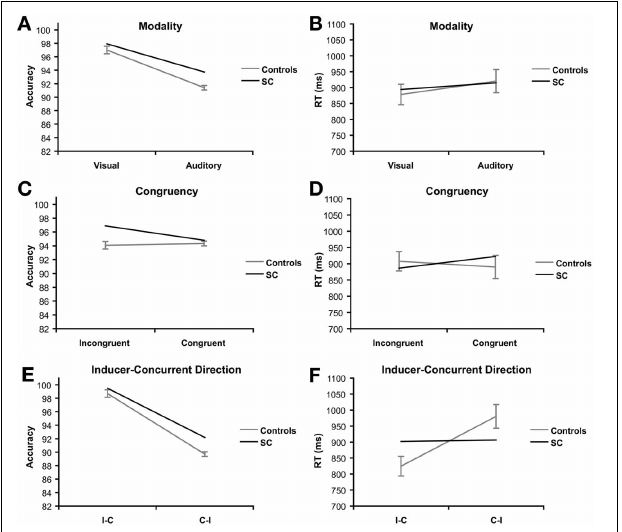
FIGURE 4 | Priming task: 2 × 2 interaction effects of synesthete SC and controls ( N = 16). Interactions are plotted for three factors of interest: modality refers to the visual or auditory presentation of the stimuli. Congruency refers to whether the type of tastes of the prime and target words were congruent (e.g., sweet–sweet) or incongruent (e.g., sweet–sour). Direction refers to whether the prime and target words were presented in SC’s inducer-concurrent (I-C) direction or concurrent-inducer (C-I) direction. The interaction between modality and congruency are presented for accuracy (A) and reaction time (B) . The interaction between inducer-concurrent direction and congruency are presented for accuracy (C) and reaction time (D) . The interaction between modality and inducer-concurrent direction are presented for accuracy (E) and reaction time (F)